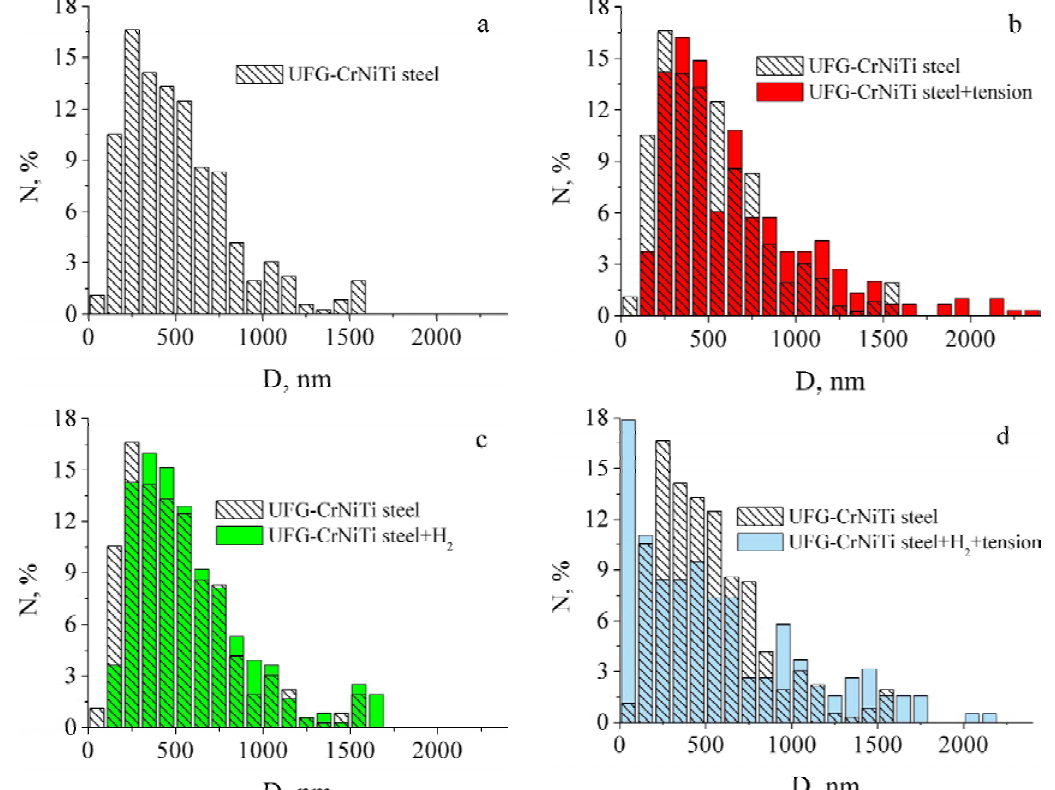
Fig. 8. Comparison of the (sub)grain size distributions in UFG-CrNiTi steel after different treatments: a – initial state (as-ABC-pressed); b – combined diagrams for initial state and initial state + tension; c – combined diagrams for initial state and initial state + hydrogen charging for 100 hours; d – combined diagrams for initial state and initial state + hydrogen charging for 100 hours + tension to fracture.